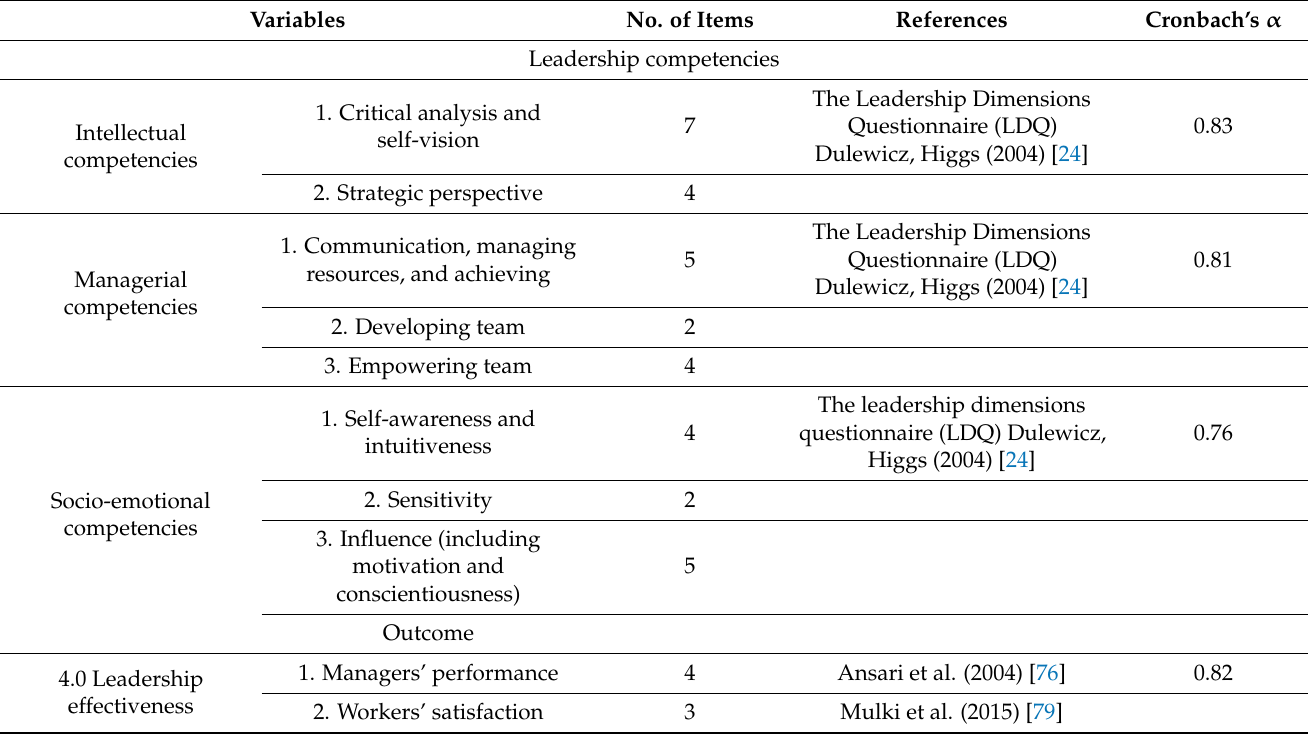
Table 1. Key variables used in the